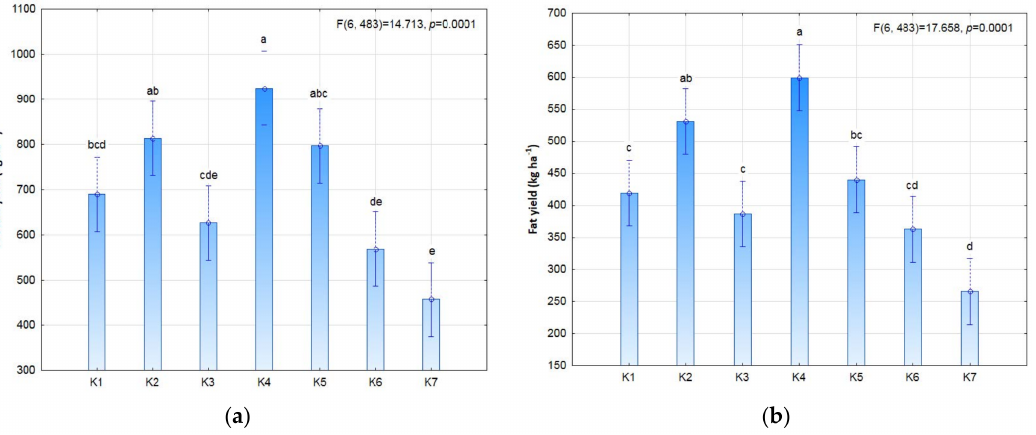
Figure 5. Protein yield ( a ) and fat yield ( b ) of soybean depending on photostimulation treatment. Different letters indicate significant differences between means. Significant effects at p <